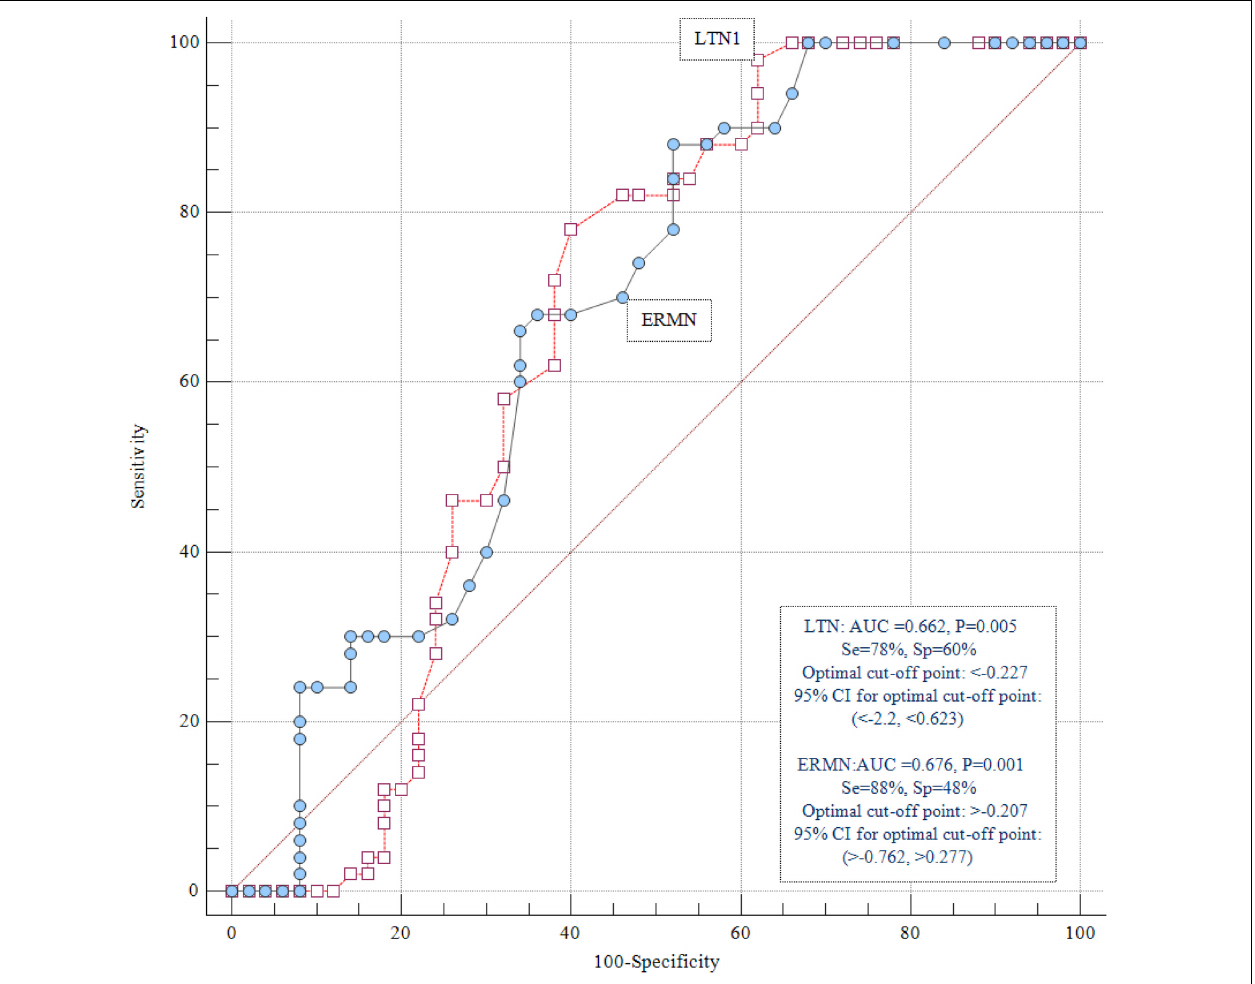
FIGURE 3 | ROC curve analysis. ERMN and LTN1 transcript levels displayed diagnostic power of 0.676 and 0.662,